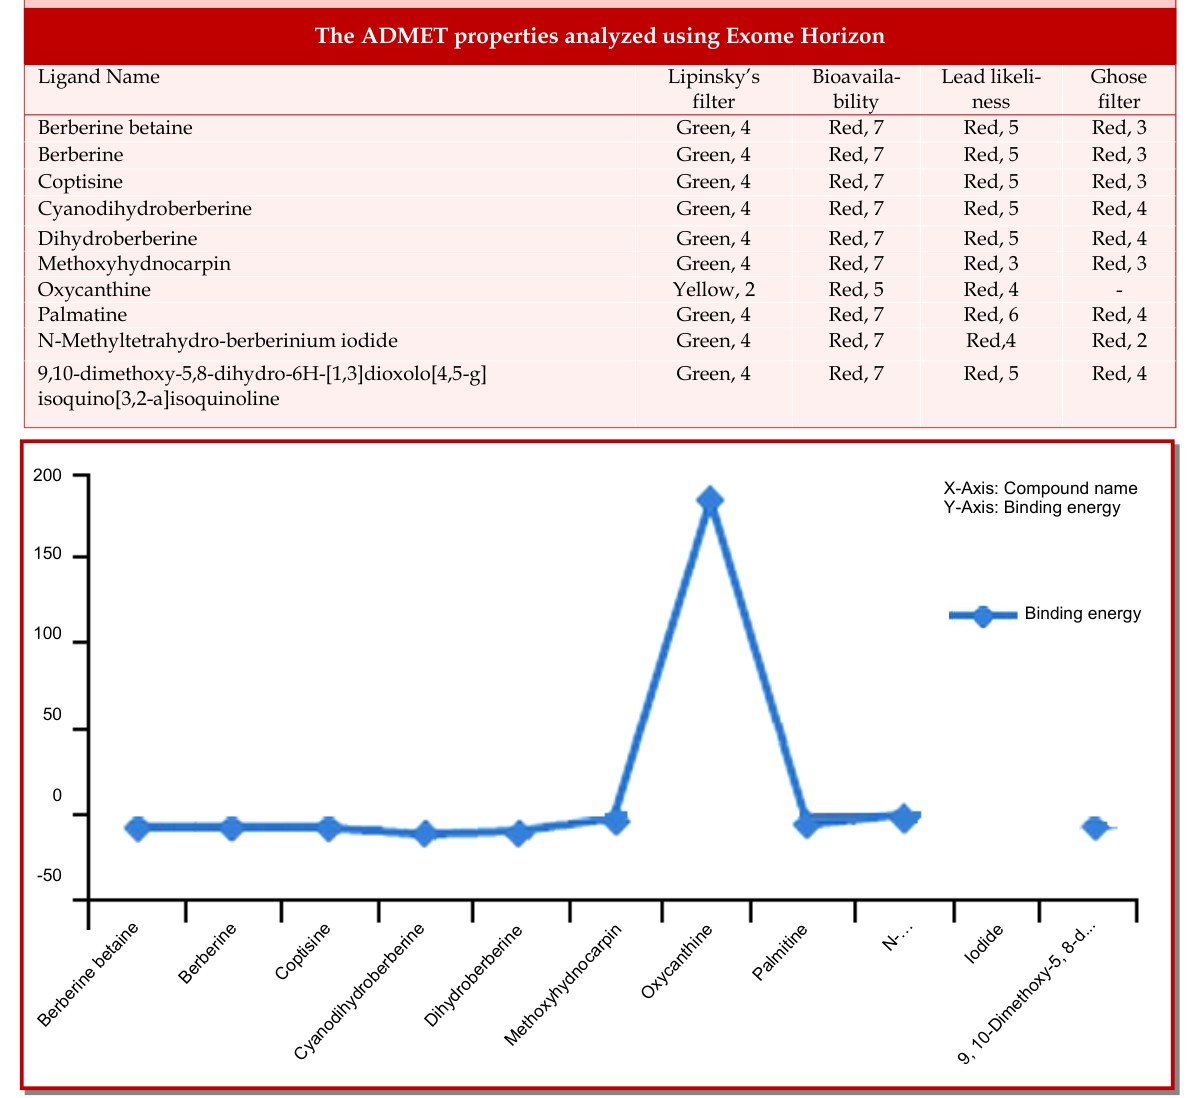
Figure 1: The binding energy calculation of the drugs against the